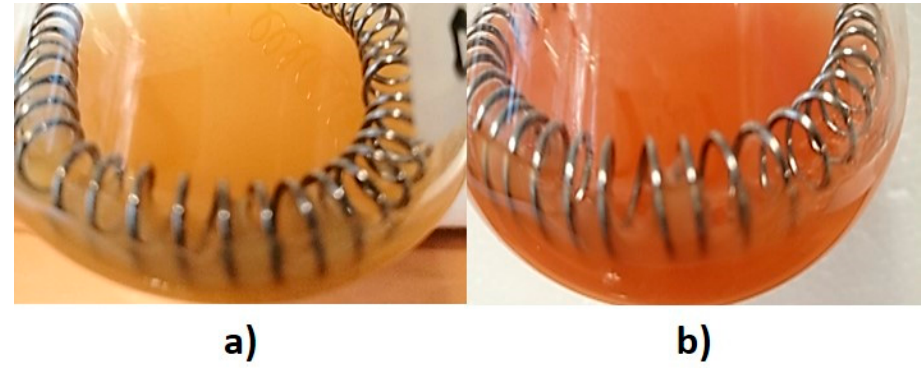
Figure 1. Micrococcus sp. culture incubated for 120-h in M9 medium supplied with ( a ) glucose or ( b ) glucose and Na 2 SeO 3 . The color variation indicates the formation of elemental Se (Se 0 ). Micrococcus sp. produced spherical and highly regular SeNPs, which were sur- rounded or embedded by a material with low electron emission yield deriving from bac- terial cells (Figure 2a,a1), being in line with most of the previous reports on biogenic NMs [10,27].